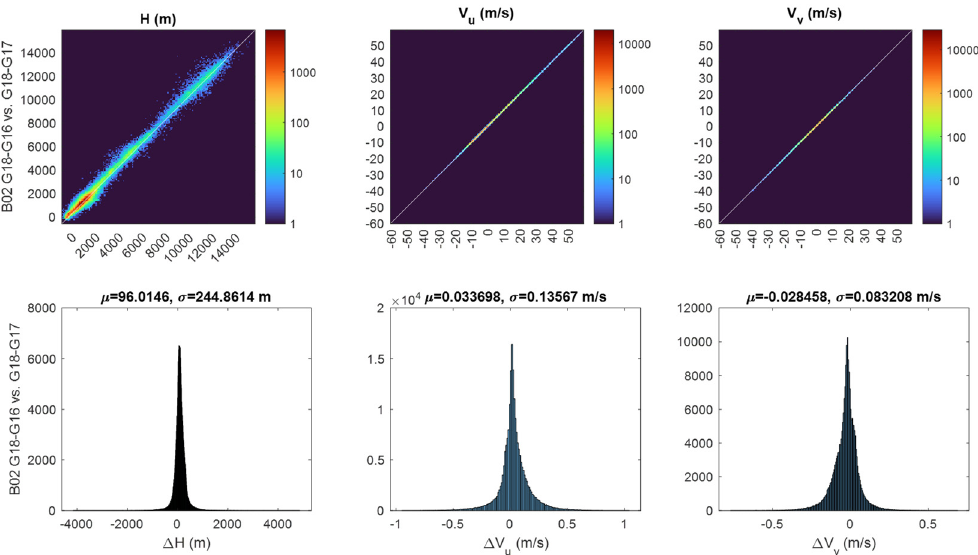
Figure 4. Log-density plots of GOES-18 plus -17 versus GOES-18 plus -16 Stereo-Wind Retrievals where there is Triple Coverage. There are N = 212,304 colocated retrievals in the difference histograms. If the retrieval errors were independent with similar statistics for each pairing, then the difference statistics would be consistent with individual statistics that are 1 √2⁄ of the sigma of the difference statistics, i.e., two-satellite retrieved height uncertainty <175 m and wind velocity uncertainty <0.1 m/s. Note: GOES-18 Preliminary, Non-Operational Data.